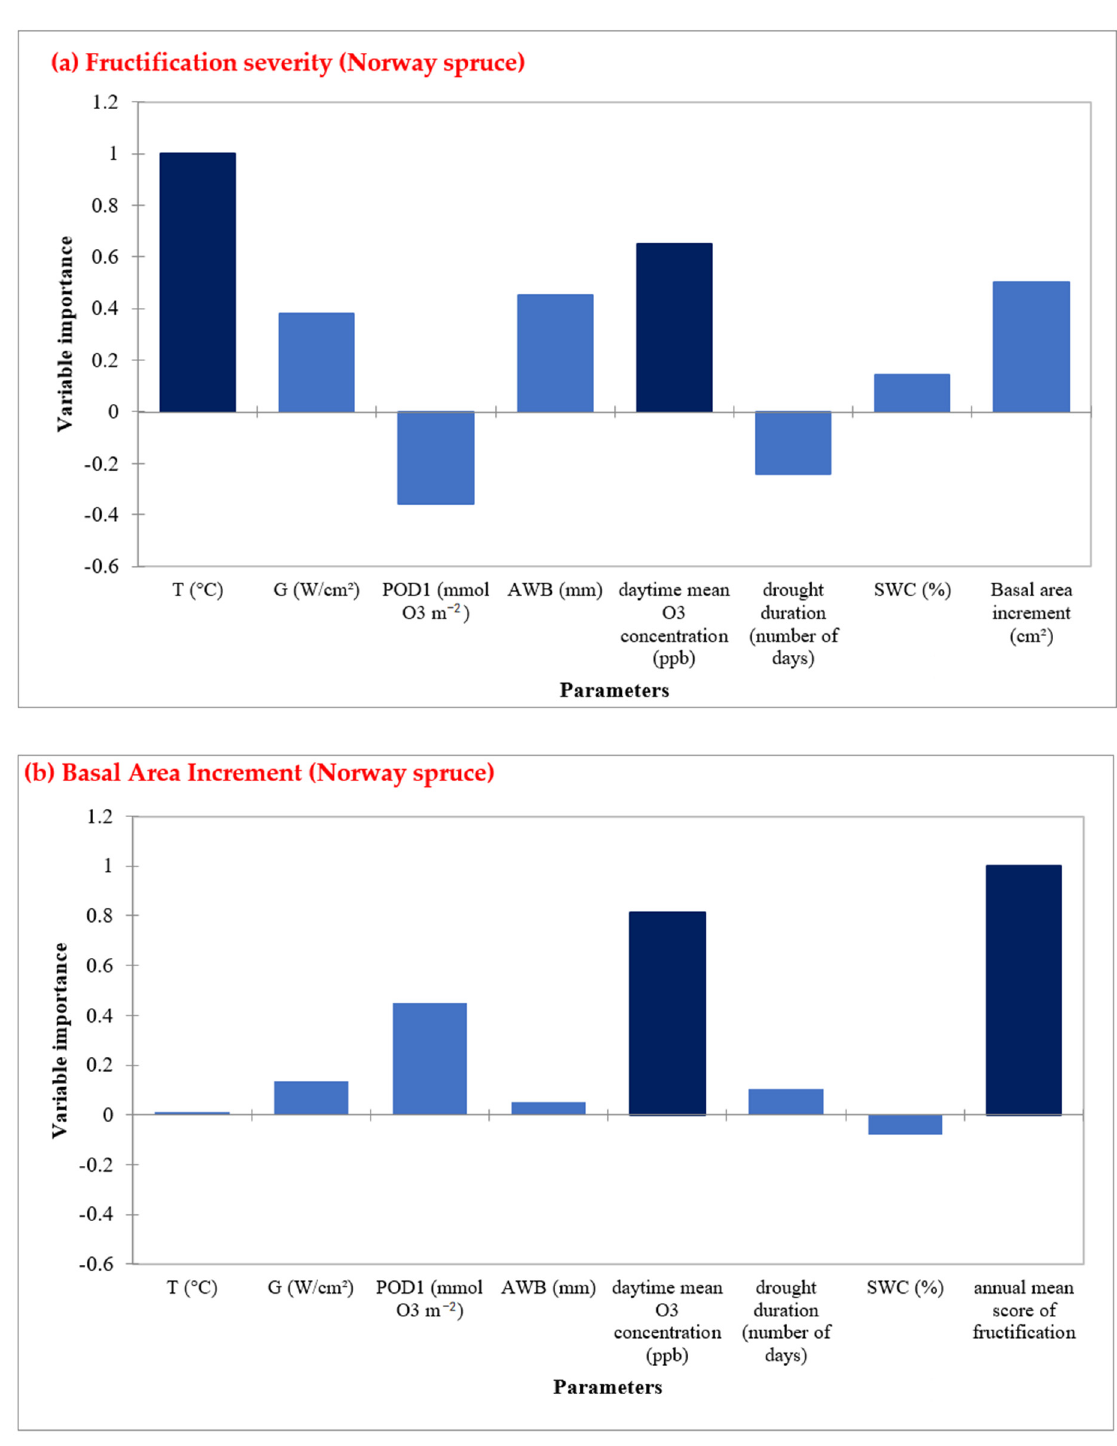
Figure 6. Random Forest Analysis for Norway spruce, showing the most important predictors in determining ( a ) fructification, and ( b ) Basal area increment in five sites during the time period 1998–2019.